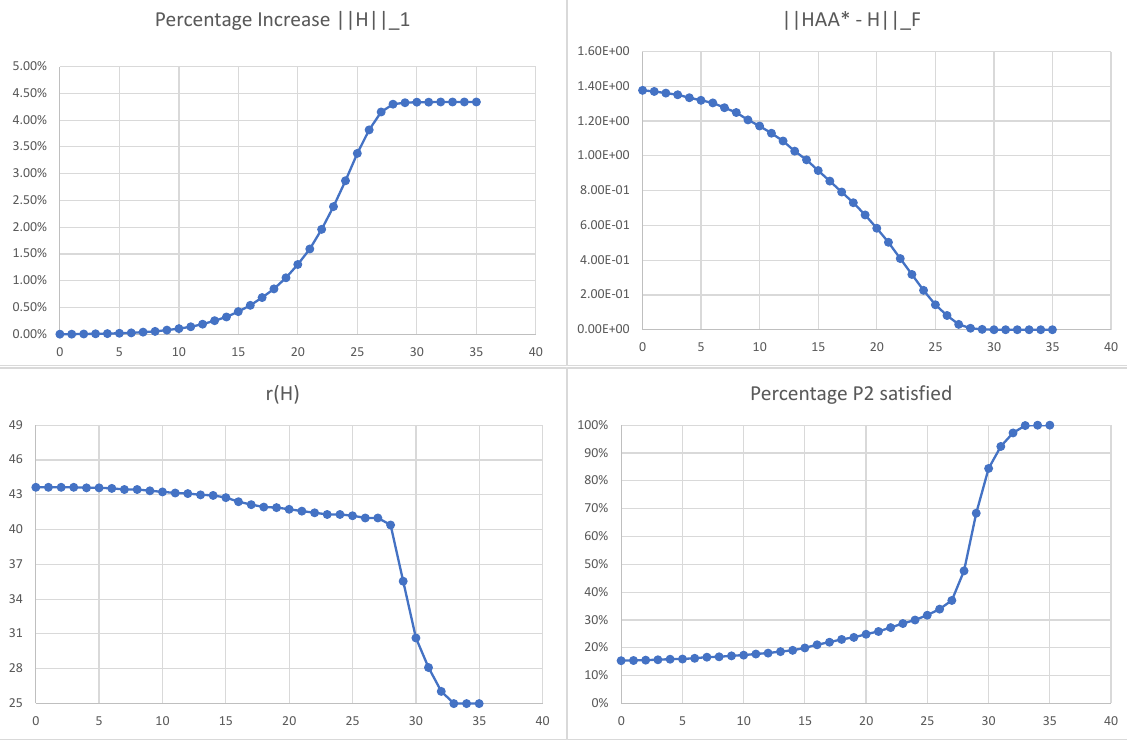
Figure 5 Penalized 1-norm